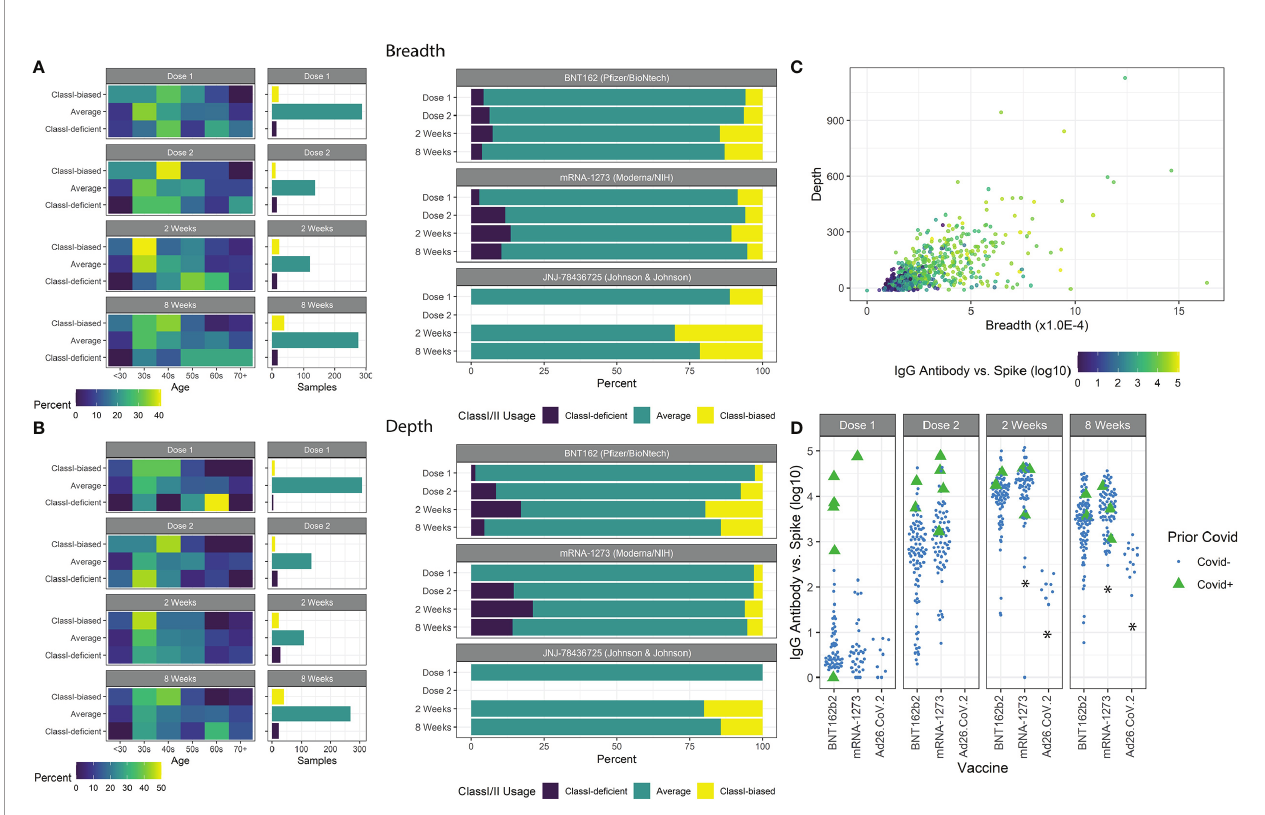
FIGURE 3 | Class-I/II patient extremes. (A) Age groups of patients with breadth z-scores <-1, >1, and between -1 and 1 are shown with the number of samples in each group. Class-I-biased patients were more likely to be younger, while Class-I-de fi cient patients were more likely to be older. Ad26.COV2.S vaccines resulted in a higher proportion of Class-I-biased patients. (B) Similar trends were observed using depth z-scores. (C) Spike-speci fi c antibody serology was correlated with both breadth and depth. (D) Prior covid infection was strongly associated with antibody counts. mRNA-1273 vaccination resulted in higher antibody counts and Ad26.COV2.S vaccination resulted in lower counts